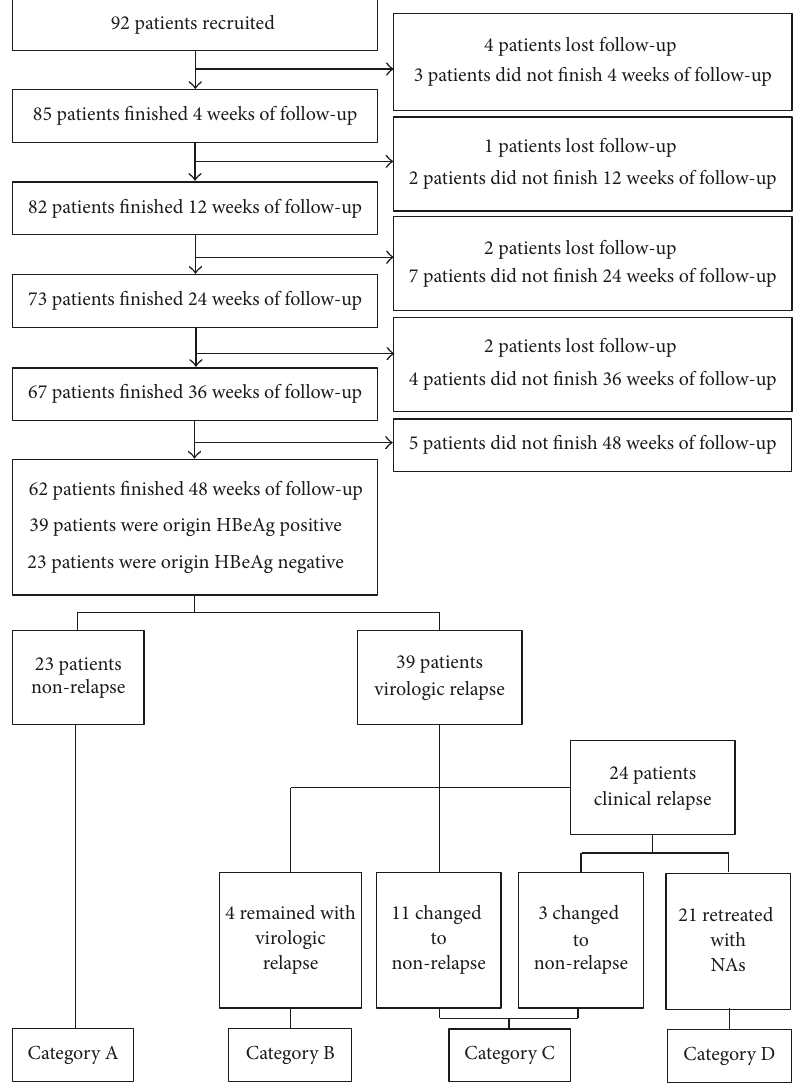
Figure 1: Flow chart of patient recruitment and clinical development.